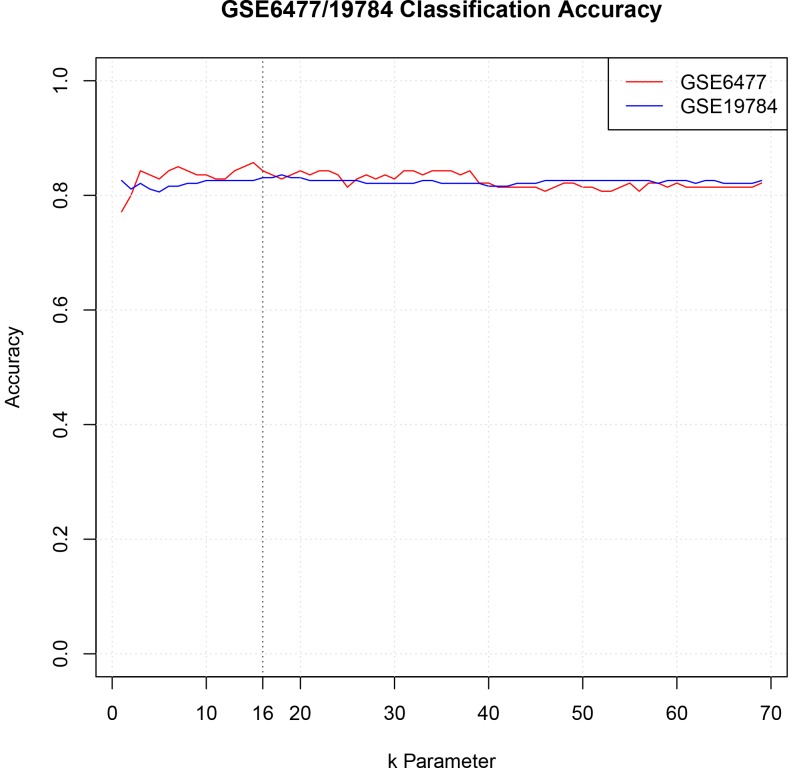
GSE6477/19784 classification accuracy for different k values in KNN.When k equals 16, both datasets have good classification accuracy.